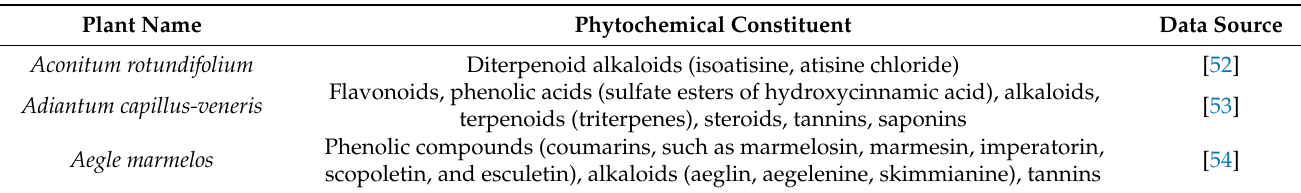
Table 3. Major phytochemicals present in ethnomedicinal plants used for curing jaundice in Himachal Pradesh. Plant